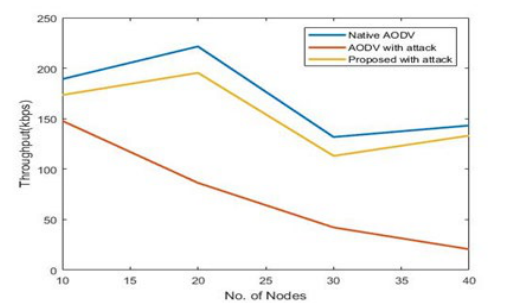
Table 2. Simulation Parameters